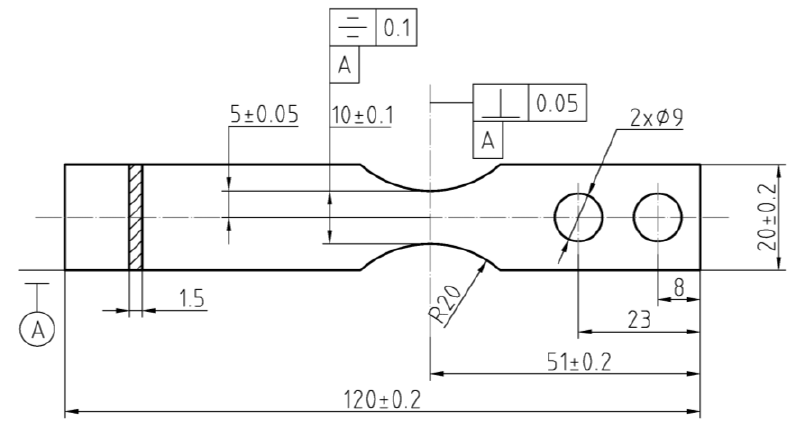
Figure 1. Sketch of the fatigue test specimen.